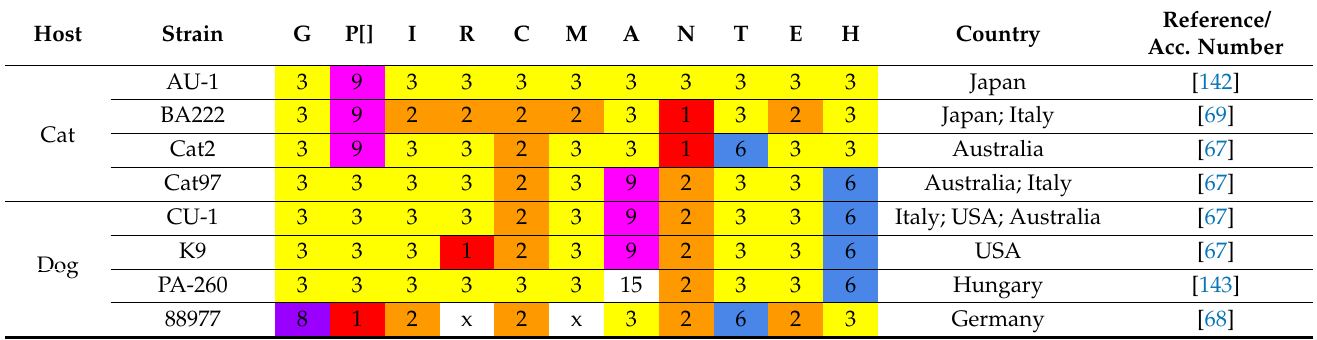
Table A8. Domestic animals’